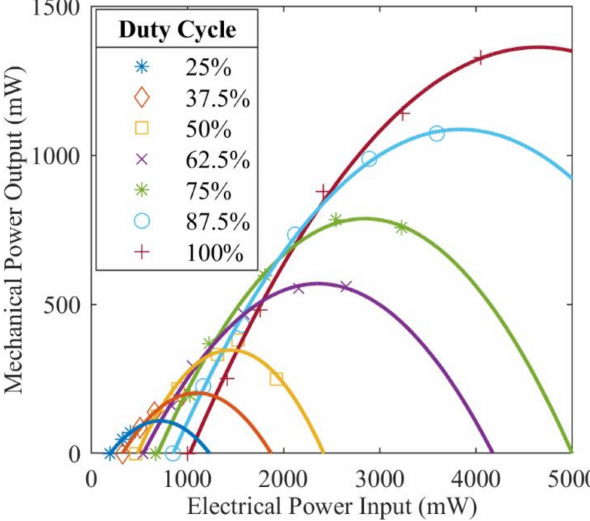
Figure 8. Mechanical power output as a function of electrical power input from measured data of seven duty cycles. Each duty cycle’s data set is fitted with a second-order polynomial, all of which have a minimum correlation coe ffi cient of 0.978. These polynomials were used to convert measured electrical power consumption into mechanical power output when the motor is subjected to unknown loads. Although not included in this diagram, the factory specifications for no-load and stall conditions support the measured data and the resulting trend